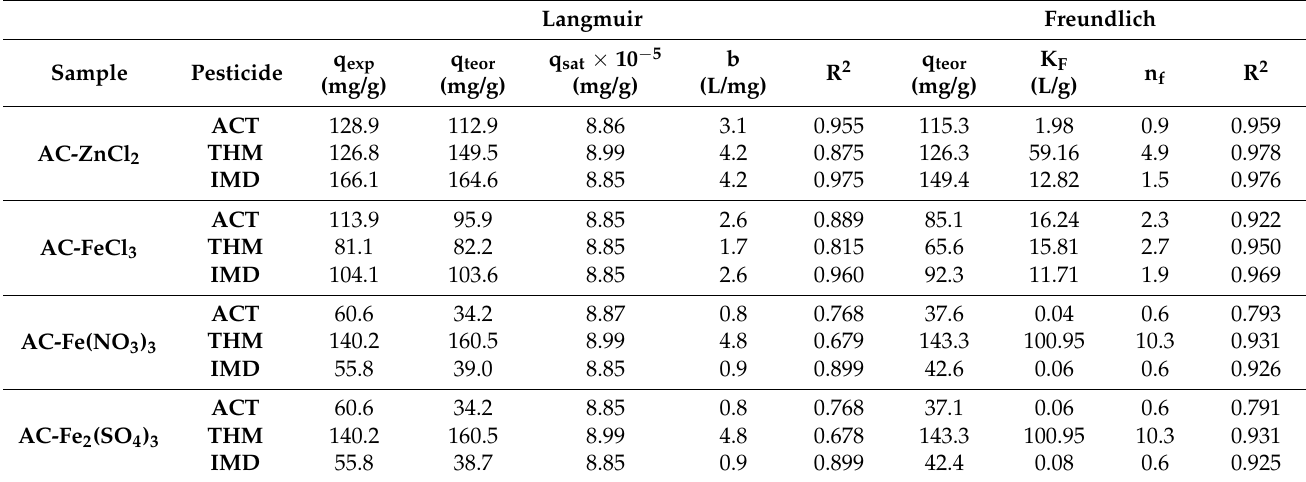
Table 5. Isotherm model parameters for the adsorption of ACT, THM, and IMD onto the carbon materials: the Langmuir and Freundlich models.